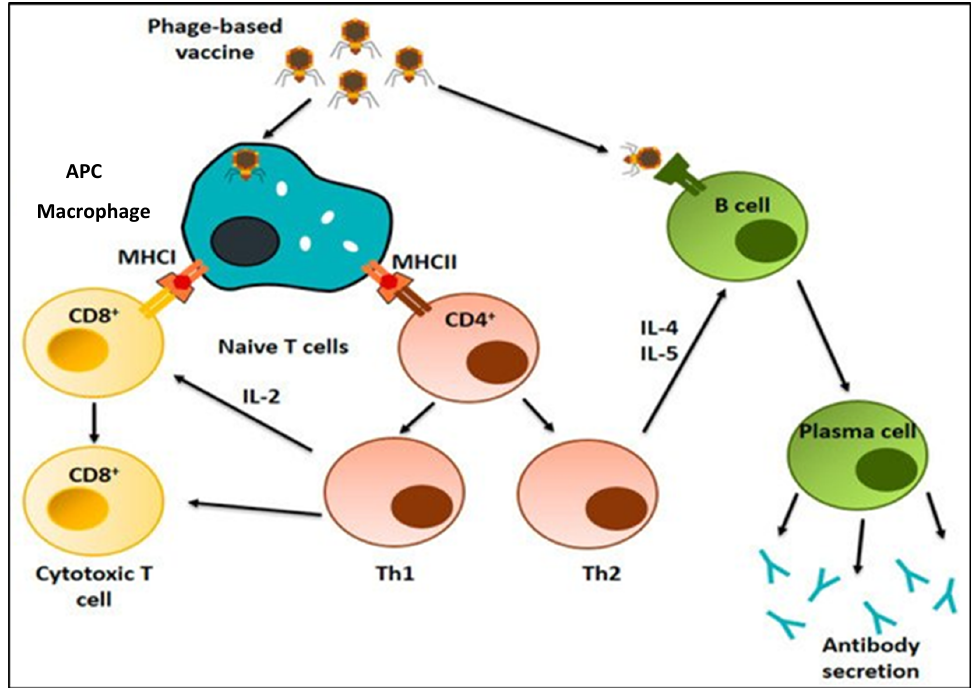
Figure 3. Phage ‐ based vaccines stimulate both cellular and humoral immune responses. T cells are activated as a result of their presentation by MHC ‐ I and MHC ‐ II molecules. Phage particles may also activate the formation of plasma cells to secrete antibodies [36]. Reproduced with permission from [Jorge Benavides], [Vaccines]; published by [MDPI], [2020]”.